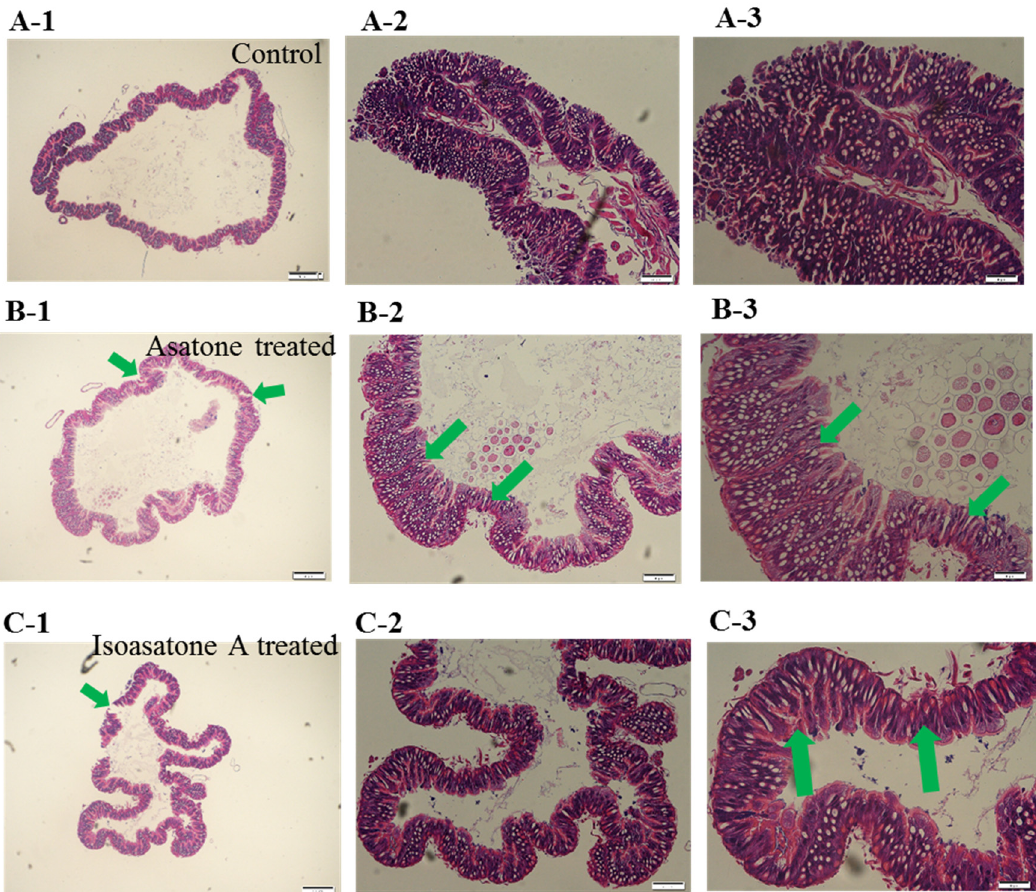
Figure 3. Midgut histopathology of Spodoptera litura after treatment with each compound asatone and isoasatone A compared with control. ( A ) Control feeding diet only, ( B ) test group on asatone diet, and ( C ) test group on isoasatone A diet. Note: label 1,2,3 present different magnification.